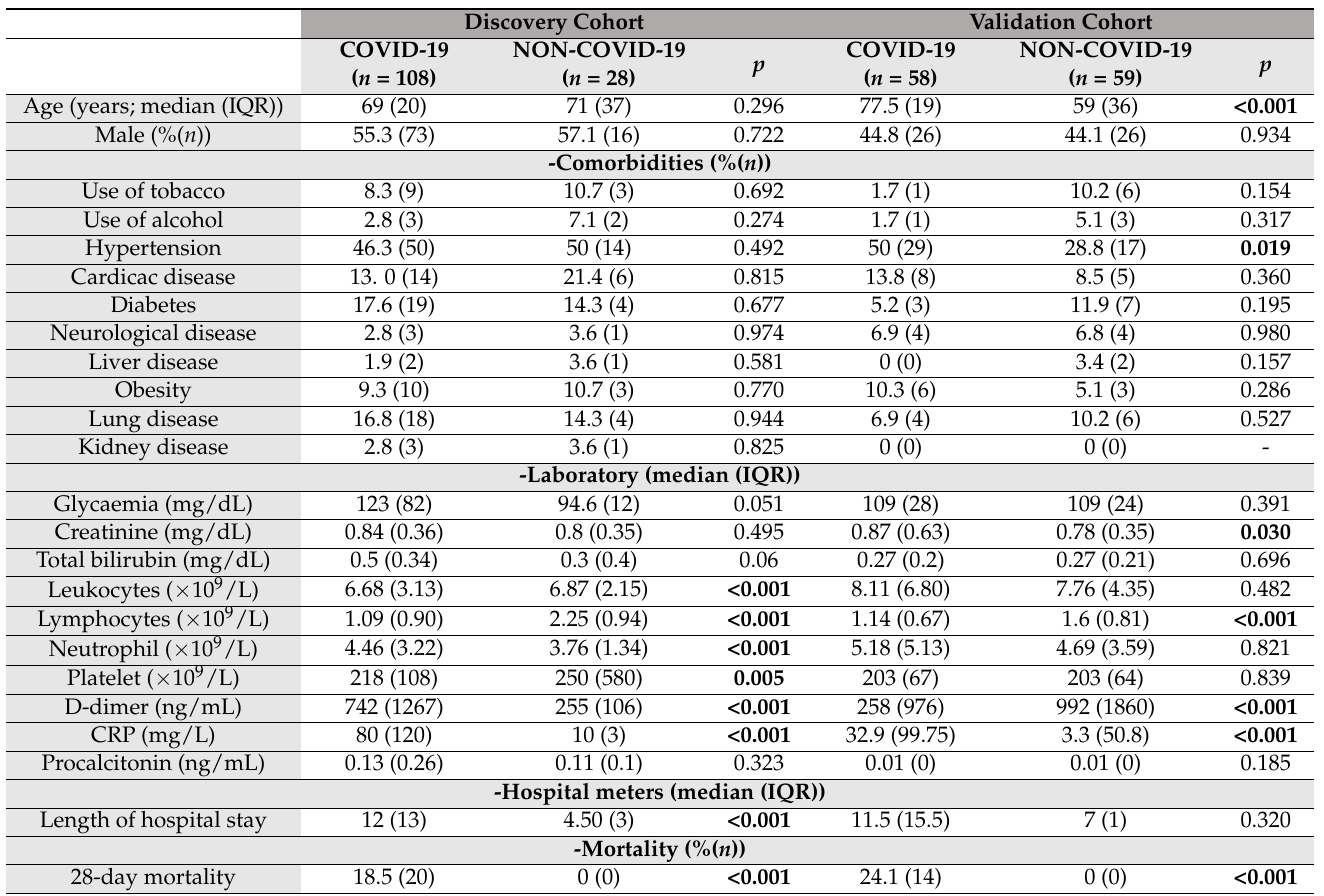
Table 1. Clinical characteristics of COVID-19 and non-COVID-19 patients in both the discovery cohort and validation cohort. Continuous variables are represented as median, (interquartile range, IQR); categorical variables are represented as %, ( n ). CRP, C-reactive protein. The bold is to indicate statistical